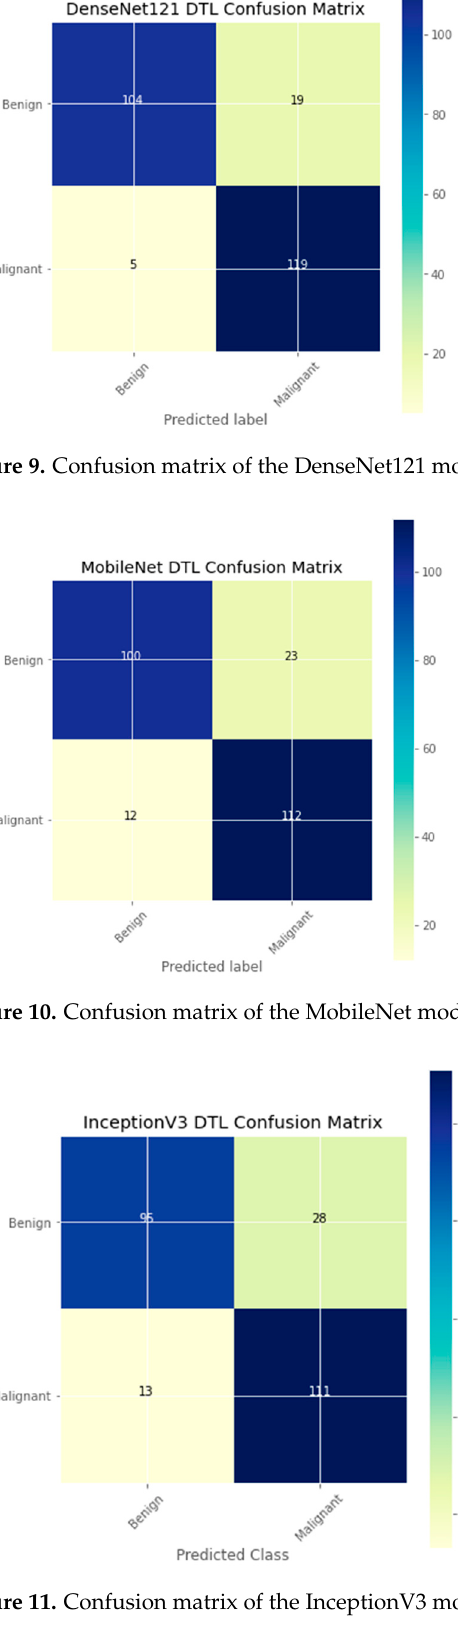
Figure 11. Confusion matrix of the InceptionV3 model.